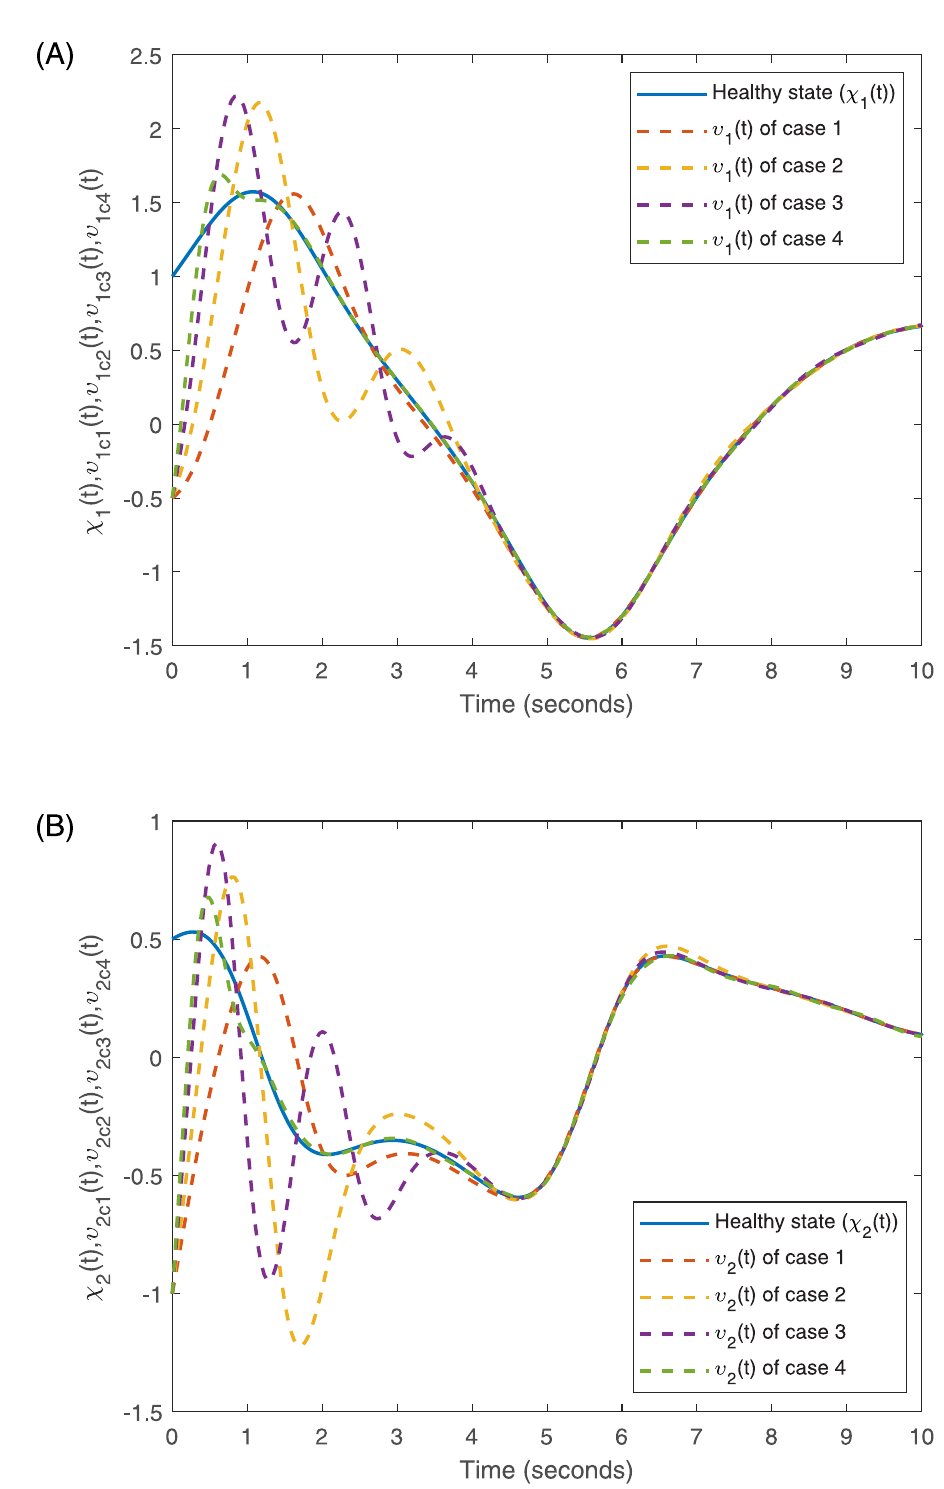
Fig 5. Response of the state for the healthy and diseased CACS for cases 1–4.